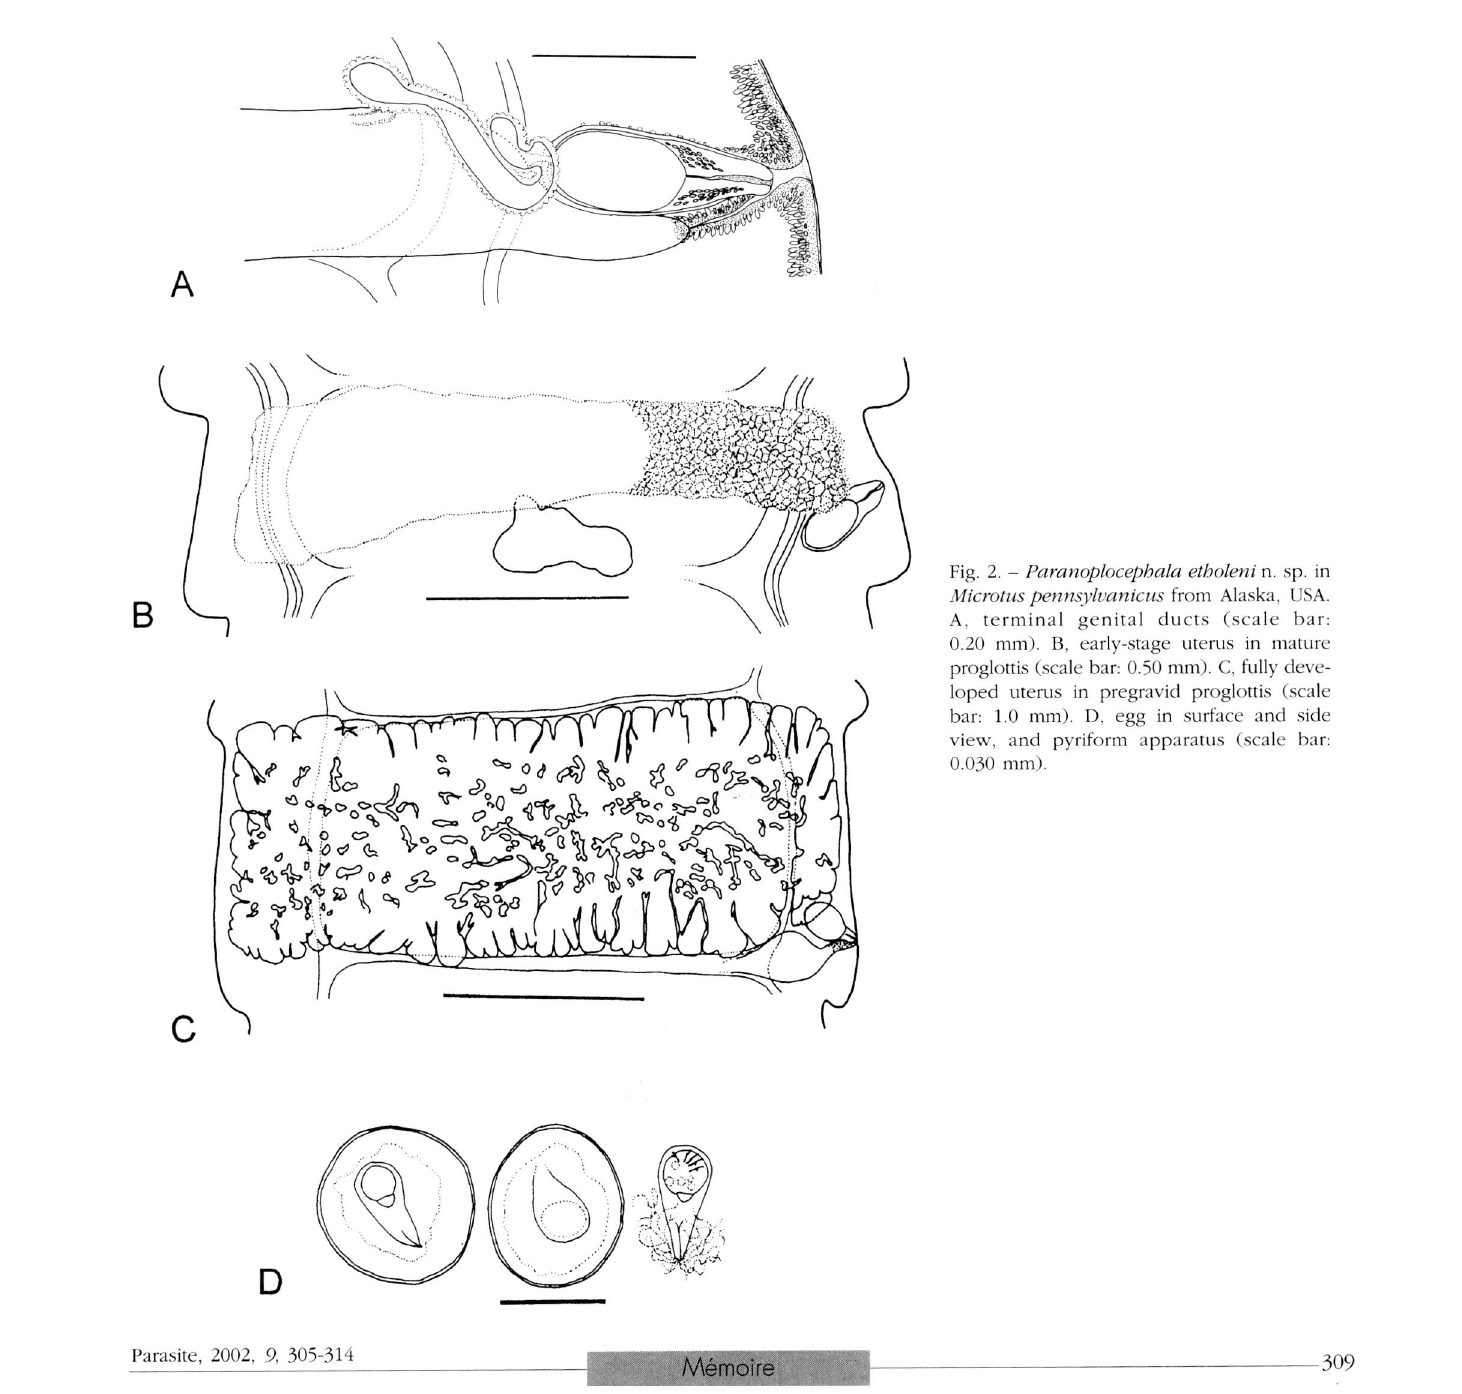
Fig. 2. - Paranoplocephala etholeni n. sp. in Microtus pennsylvanicus from Alaska,